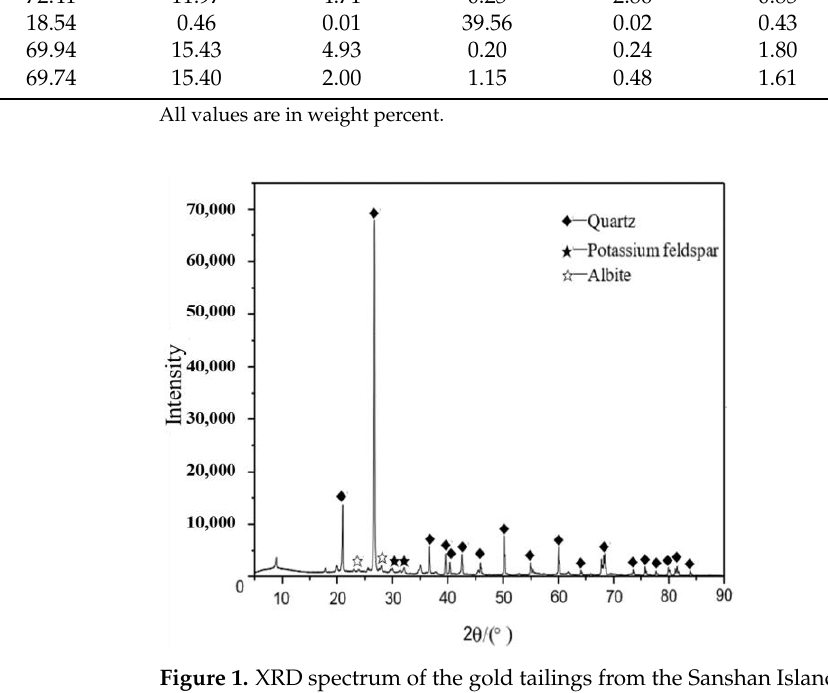
Table 2. Chemical composition of the various raw materials used for foam ceramic preparation.